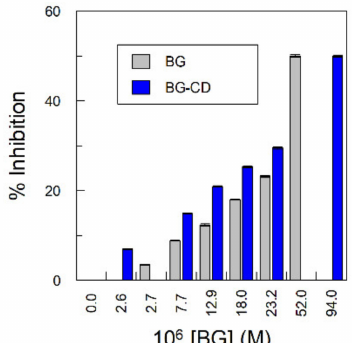
Figure 6. Percentage of inhibition on the 2,2–diphenyl–1pycrilhydrazyl (DPPH • ) radical content for butyl gallate in the absence (BG) and in the presence (BG–CD) of CDs ([ β -CD] = 11 mM), at time 1.8 h and T = 25 ± 1 ◦ C.